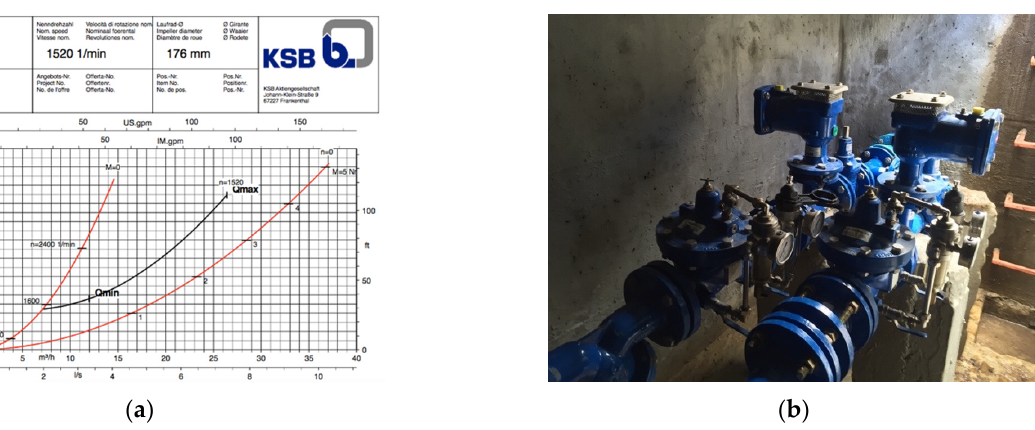
Figure 5. Field conditions: ( a ) PAT Etanorm 32-160 characteristic curve; ( b ) Pressure reducing valve.